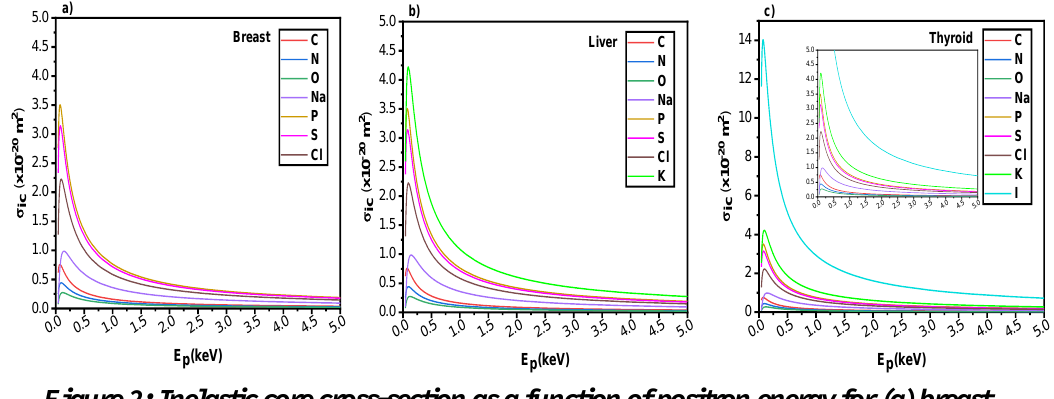
Figure 2: Inelastic core cross-section as a function of positron energy for (a) breast, (b) liver, and (c) thyroid.